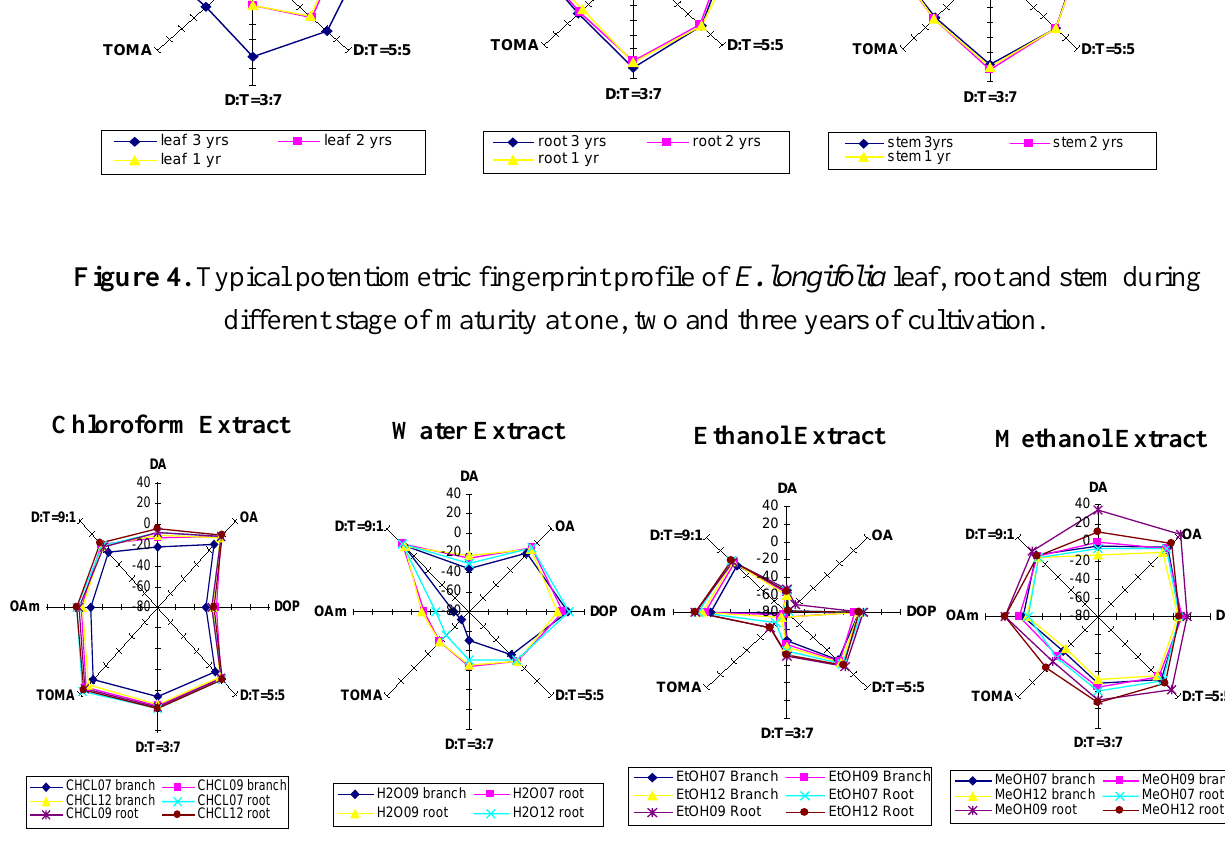
Figure 5. Typical potentiometric fingerprint profile of E. longifolia under different mode of